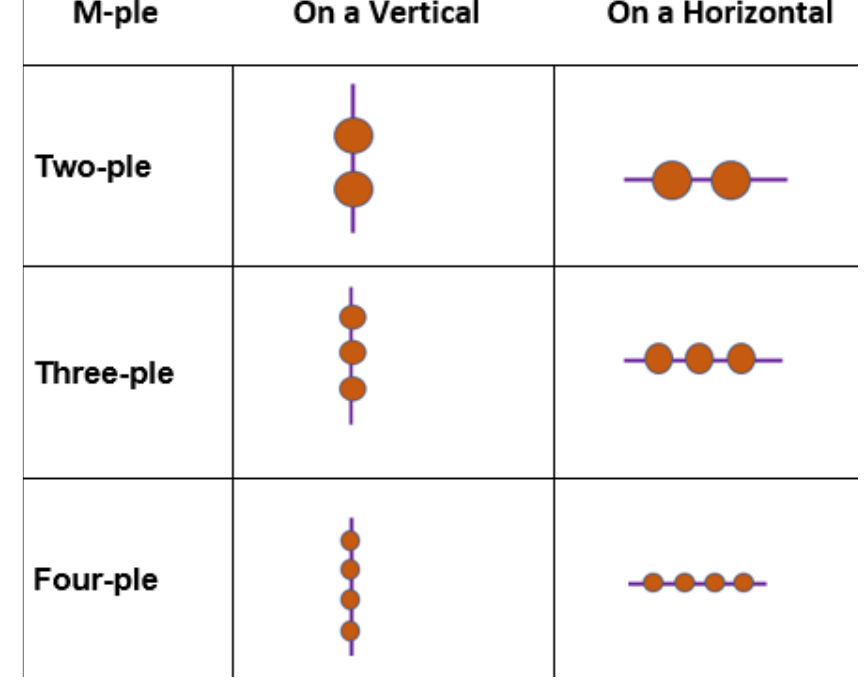
Figure 8. Examples of